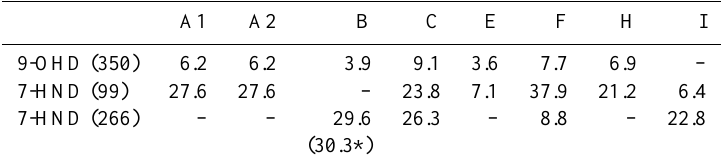
Table 4. Instrumental (GC-MS) response factors (RF) for IP 25 versus different internal standards (IS) and monitoring ions ( m/z ) from various laboratories. Each RF has been obtained from the peak area ratio IS/IP 25 using a standard solution containing equal concentrations of each analyte. *calculated from a reference sediment of known IP 25